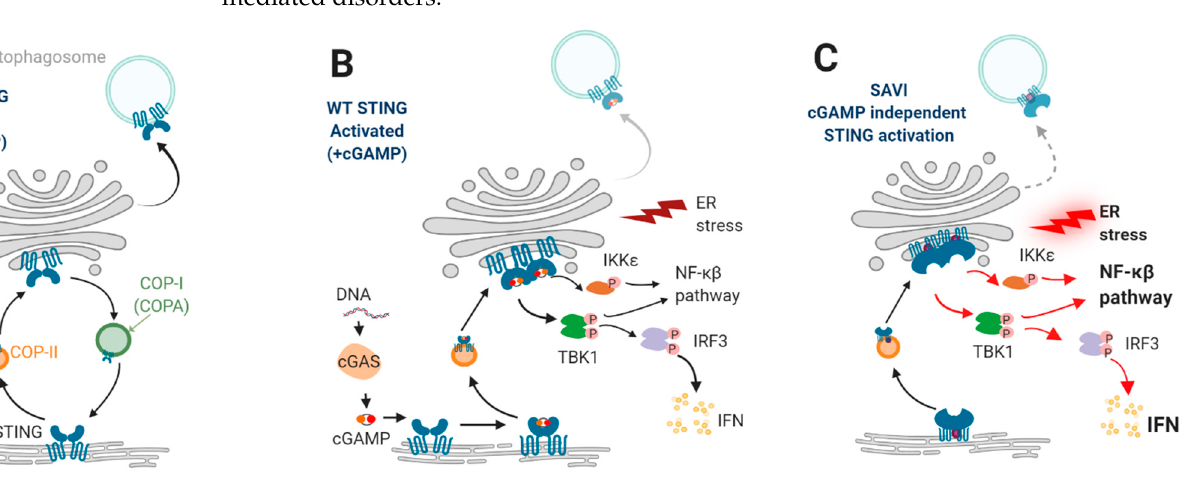
Figure 1. STING Signaling. ( A , B ) Upon DNA sensing by cGAS, cGAMP binds to wild-type (WT) STING. STING trafficks then to the Golgi and undergoes post-translational modifications. STING